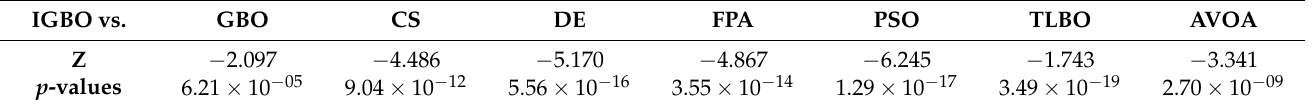
Table 5. Wilcoxon Signed Ranks test for unimodal benchmark